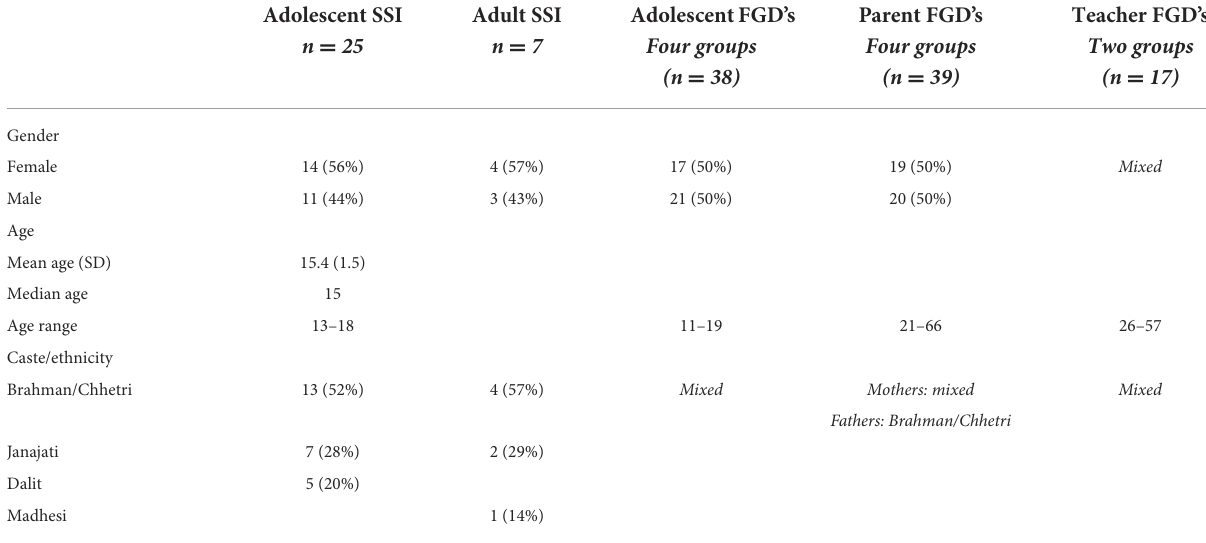
TABLE 1 Participant